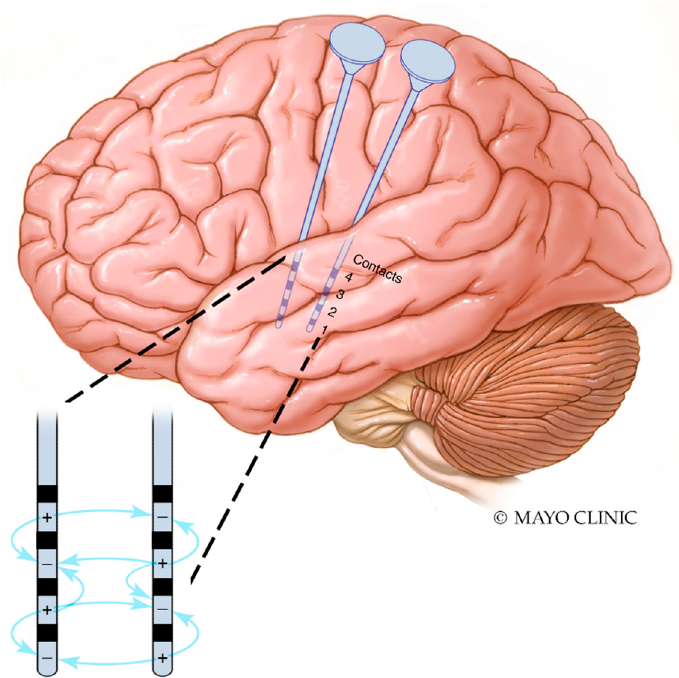
Figure 3. Interaction between cathodal and anodal contacts in proximal electrodes. Interactions between contacts in two temporal depth electrodes are illustrated. Dipoles are generated between contacts on the same electrode as well as between cathodal and anodal contacts on nearby electrodes. For the sake of simplicity, not all possible interactions are shown; dipoles are generated between all cathodes and anodes.